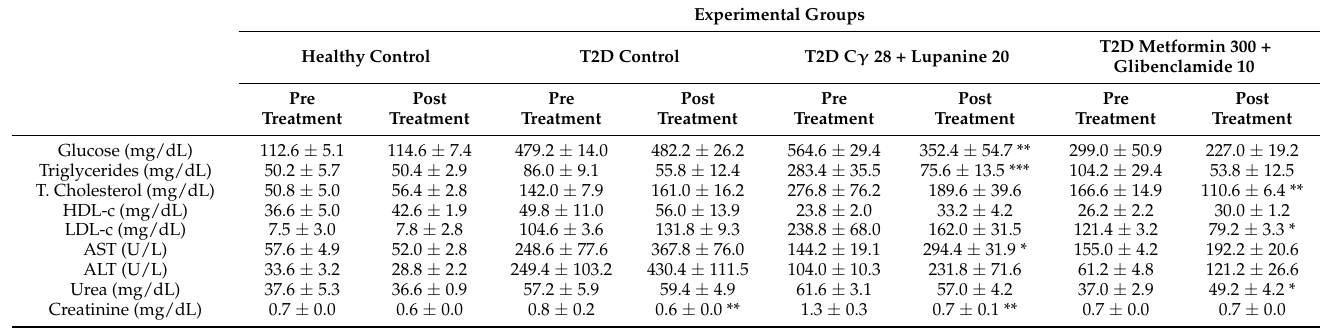
Table 1. Biochemical parameters pre- and post-treatment in different groups of